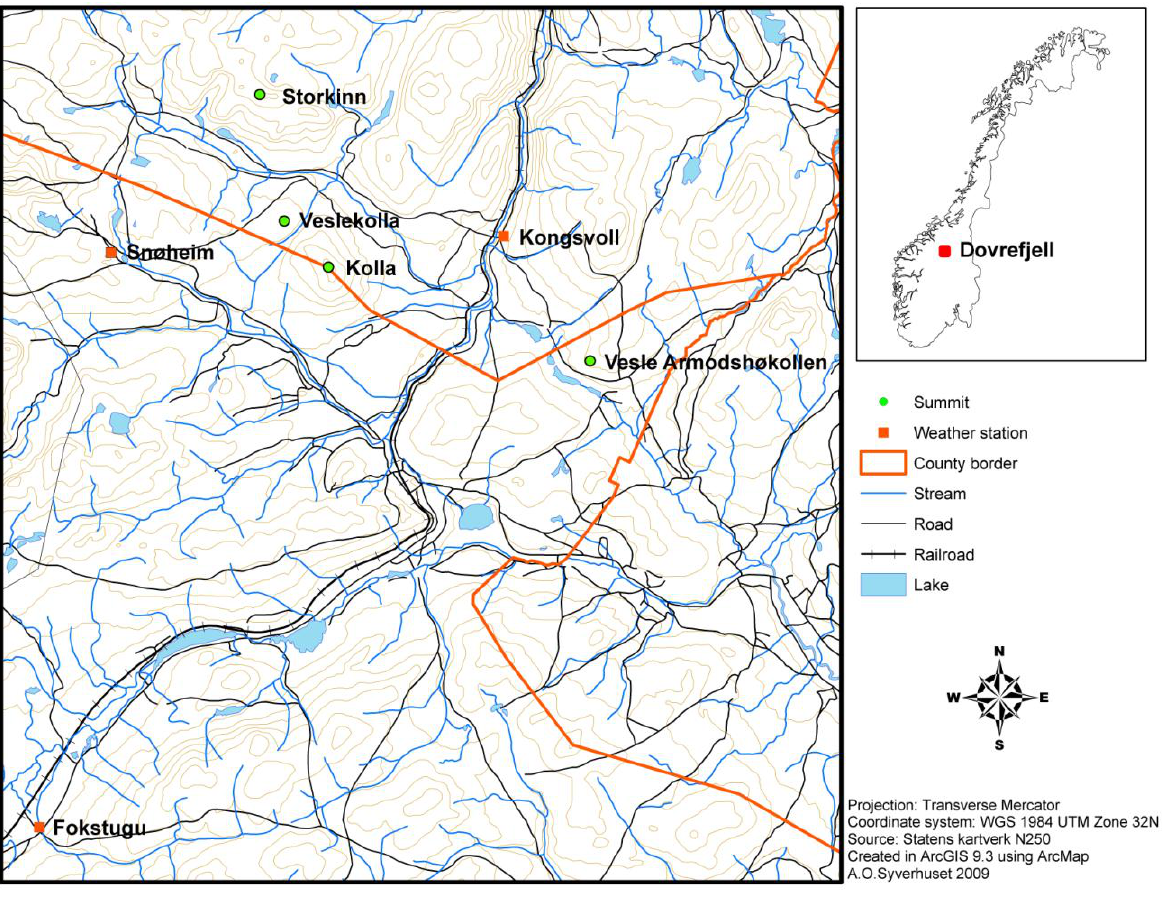
Figure 1. Map over Dovrefjell showing the location of the four summits studied; Vesle Armodshøkollen (1,161 m a.s.l.), Veslekolla (1,418 m a.s.l.), Kolla (1,651 m a.s.l.) and Storkinn (1,845 m a.s.l.), indicated by green circles and the location of the weather stations; Snøheim (1,505 m a.s.l.), Kongsvoll (930 m a.s.l.) and Fokstugu (972 m a.s.l.) indicated by red squares. The detailed map shows the area from N62º6.1′ E9º15.9′ in the lower left corner to N62º22.3′ E9º50.2′ in the upper right